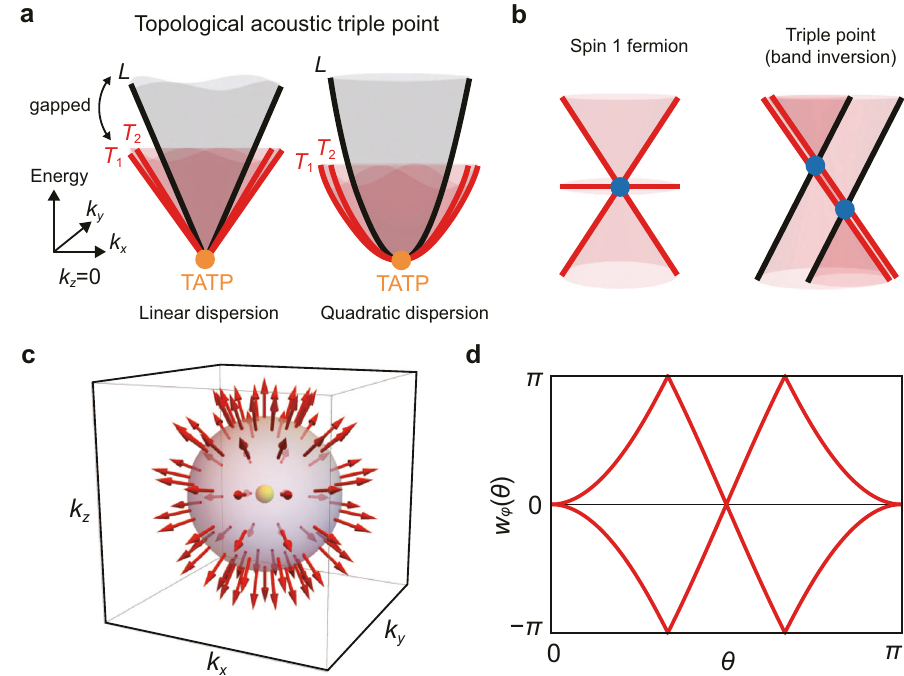
Fig. 1 Topological acoustic triple point (TATP). a TATP with q (cid:3) ð n sk ; e Þ ¼ ð 1 ; 2 Þ can appear with either a linear dispersion or a quadratic dispersion. Note that there is a gap between the L and the T modes away from the triply degenerate point. b TATP is distinct from spin-1 Weyl point, which is protected by Chern numbers. TATP is also distinct from the triple point formed by band inversion, where it is not possible to separate the highest energy band from two lower energy bands away from the triple point. c Skyrmion texture of longitudinal phonon on the sphere wrapping a TATP. The transverse modes span the tangent plane of the sphere. d Wilson loop spectrum for the transverse modes as a function of the polar angle θ computed on a sphere wrapping the TATP. j e j is given by the number of times that one of the two branches of w ϕ ( θ ) crosses π .